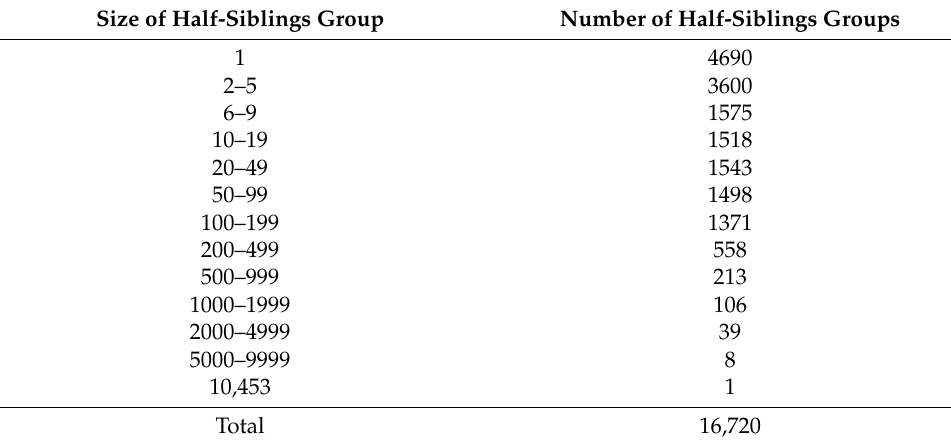
Table 2. Distribution of half-sibling groups.